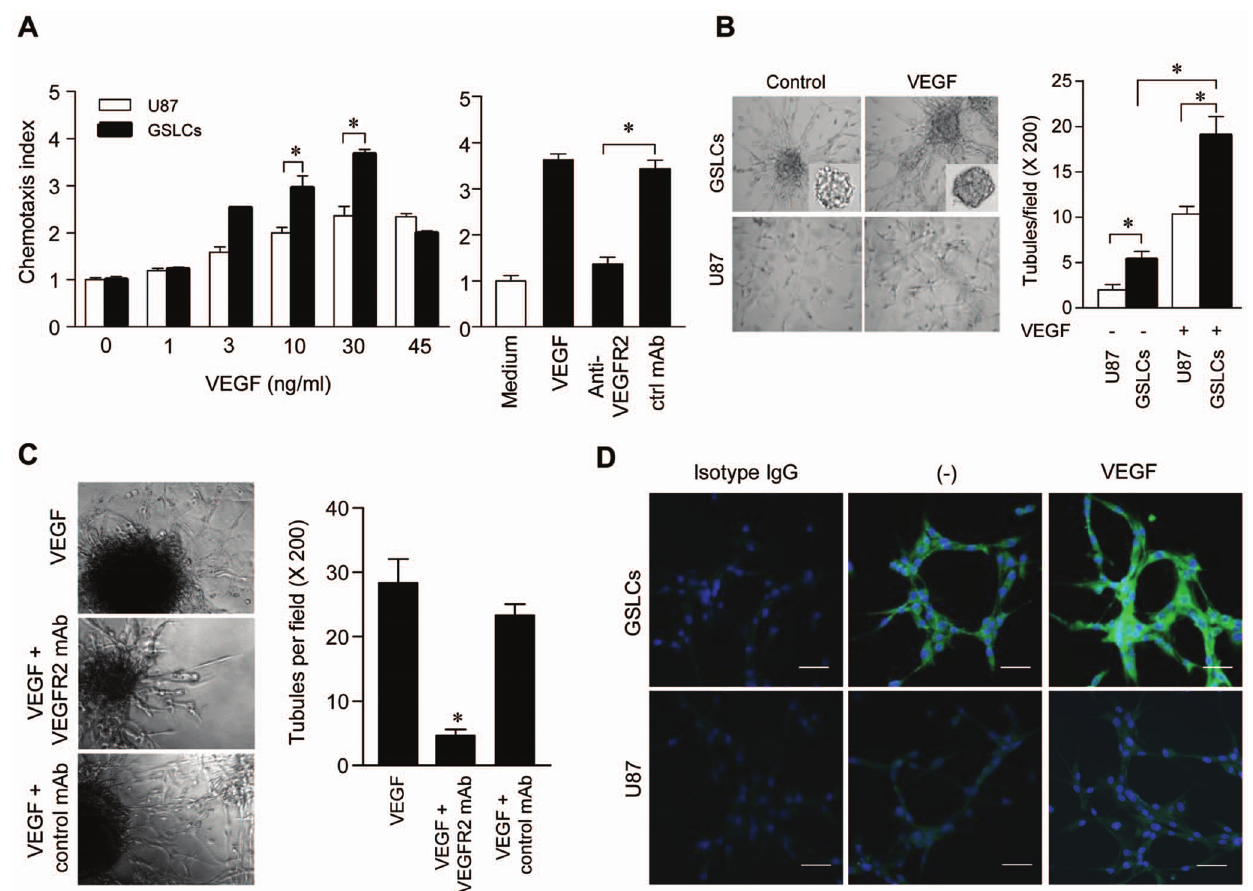
Figure 3. The function of VEGFR-2 in GSLCs. ( A ) VEGF-induced chemotactic of GSLCs ( left ). * Indicates significantly increased response shown by GSLCs compared to U87 parental cells ( p , 0.05 ). A VEGFR-2 neutralizing mAb blocked GSLC response to VEGF ( right ). Control mAB: ctrl mAb. * Indicates significantly reduced cell response in the presence of anti-VEGFR-2 ( p , 0.05 ). ( B ) Tubule formation by GSLCs treated by VEGF. B , Left : Vessel formation by GSLCs; Right : Quantitative analysis of tubule formation by GSLCs. Data represent the mean 6 SEM in triplicates. * Indicates significantly increased tubule formation by GSLCs compared to U87 cells and cells treated with VEGF versus untreated cells ( p , 0.05 ). ( C ) The effect of anti-VEGFR- 2 mAb on tubule formation by GSLCs ( left ). The black ball indicates sphere. Right : Quantitation of tubules. * Indicates significantly reduced tubule formation by GSLCs treated with anti-VEGFR-2 mAb compared to control cells ( p , 0.05 ). ( D ) VEGFR-2 expression on the tubules formed by VEGF- treated